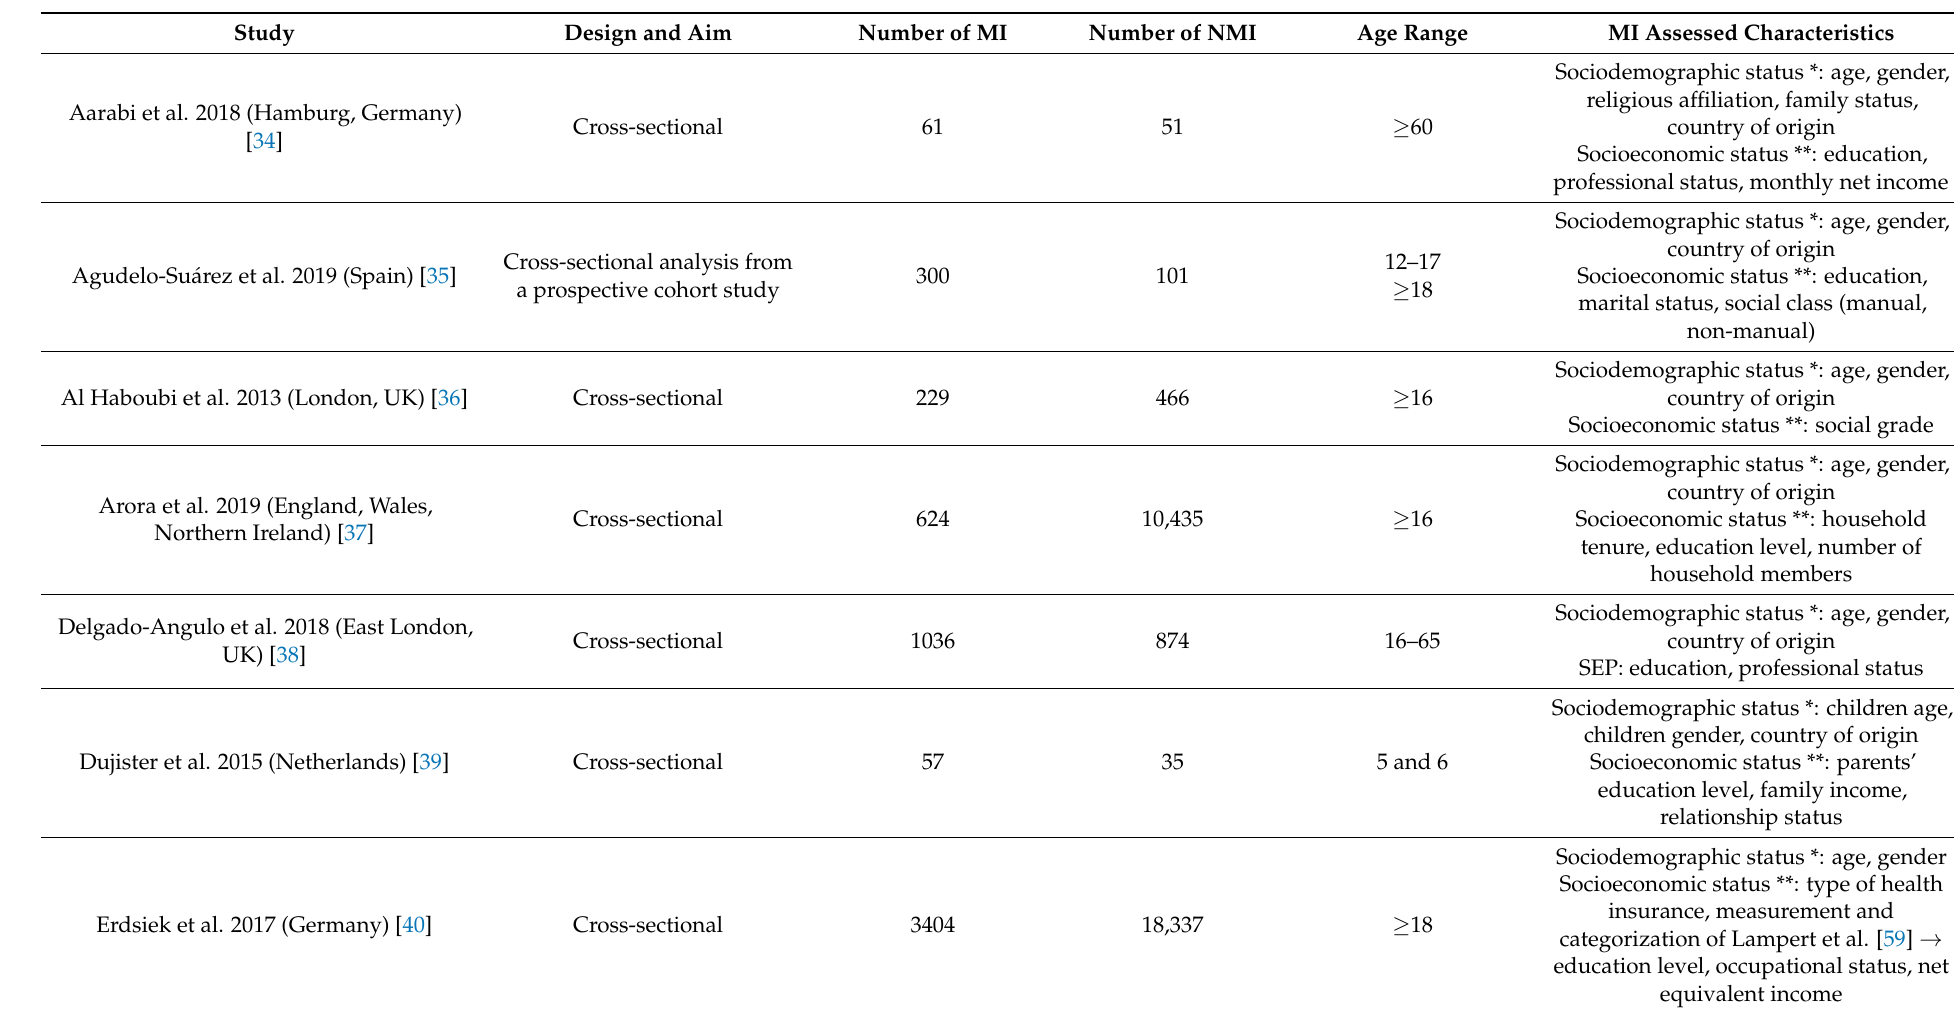
Table 5. List of included studies: design, aim, number of MI and NMI, age range, migrants assessed